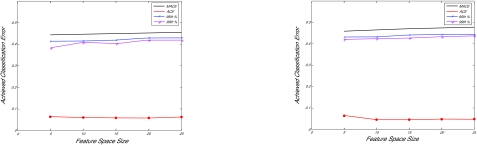
PACE analysis using a SVM-based classifier using the Fisher scoring criterion, with a 0.6 MAC threshold. Left Panel: performance without peak selection. Right panel: performance with peak selection.